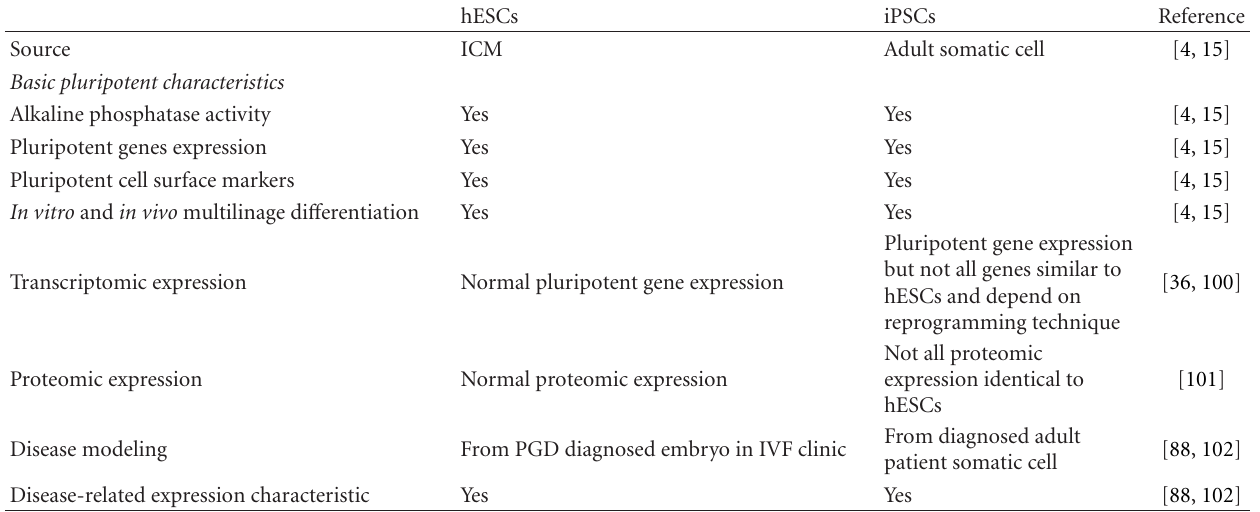
Table 2: Summarizing the similarities and di ff erences of ESC and iPSC for disease